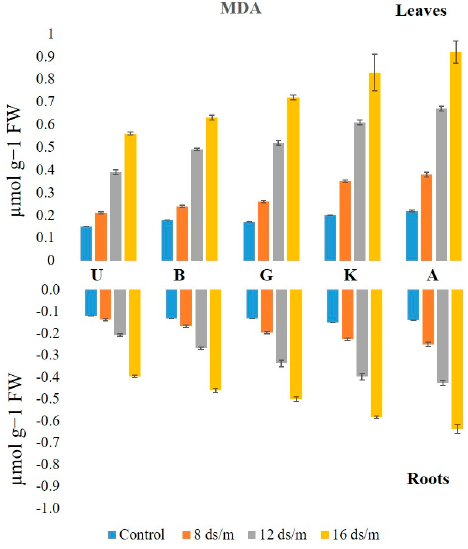
Figure 11. Effect of NaCl-mediated stress on MDA activity in roots of pistachio.